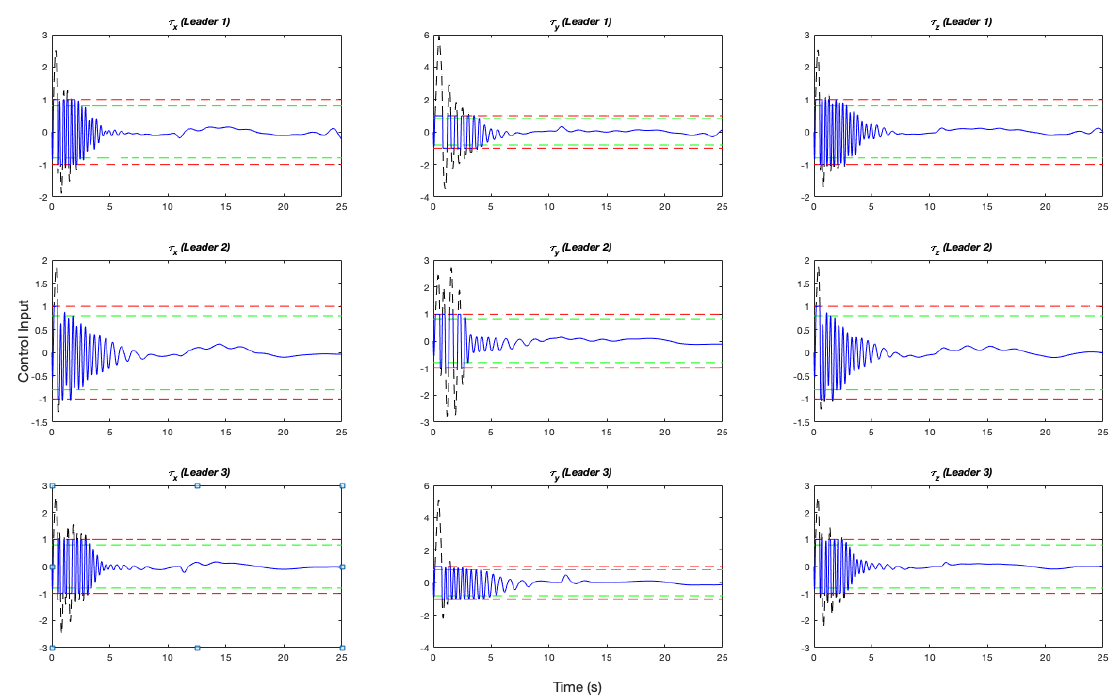
Figure 5. Control input of the leaders (blue is the actual control input and black is the commanded control input) ( µ = 1).